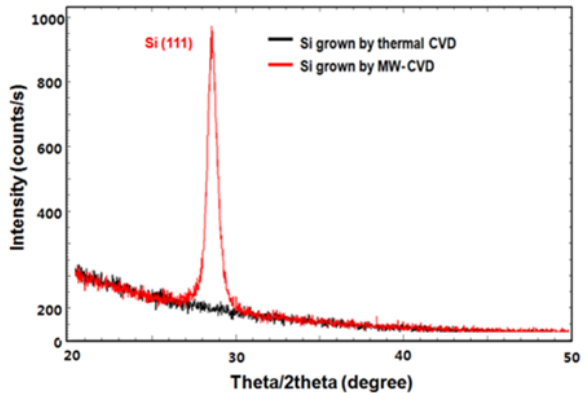
Figure 2. X-ray diffraction (XRD) rocking curves of the Si layers grown by thermal chemical vapor vapor deposition (CVD) (580 ◦ C; black) and microwave plasma-enhanced chemical vapor deposition deposition (CVD) (580 °C; black) and microwave plasma-enhanced chemical vapor deposition (MW- (MW-CVD) (430 ◦ C; CVD) (430 °C; red).